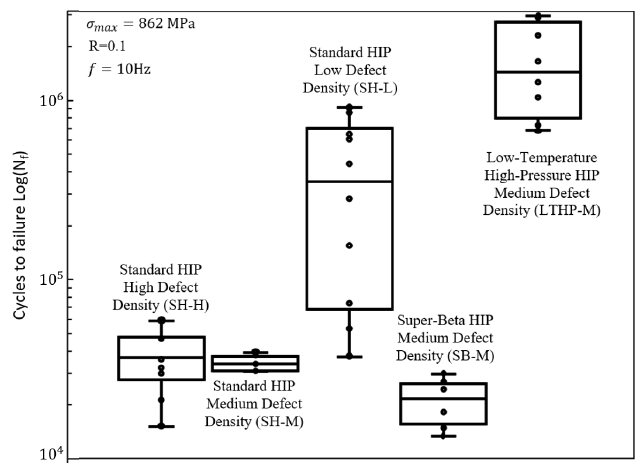
Figure 3. ASTM E-466 force controlled constant amplitude fatigue test results for five groups of AM Ti-6Al-4V specimens with different material states. The number of cycles to failure, N f , for each specimen are represented by circles. The group’s lower, median, and upper quartiles are represented by the bottom, middle, and upper lines, respectively. The range of each data set is represented by the extended brackets. Each group’s defect density (low/medium/high) refers to the initial condition, before the application of HIP.